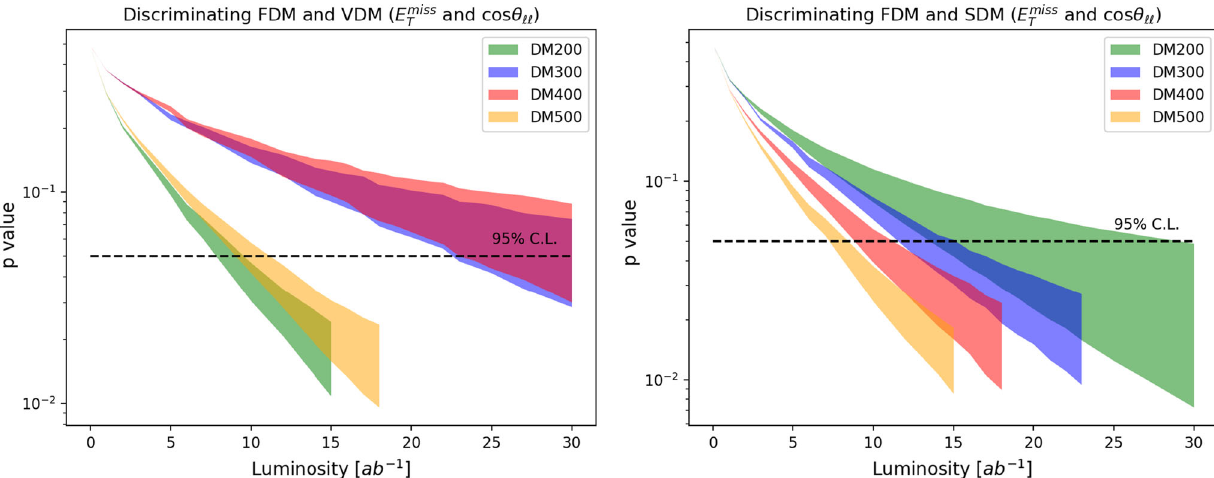
Fig. 8 Two dimensional distributions in | cos (θ (cid:11)(cid:11) ) | and E miss plane after all selection requirements for an weighted sum of all SM backgrounds T and SDM, FDM500 and VDM500, respectively. Color code is indicating the actual cross section [fb] in each bin